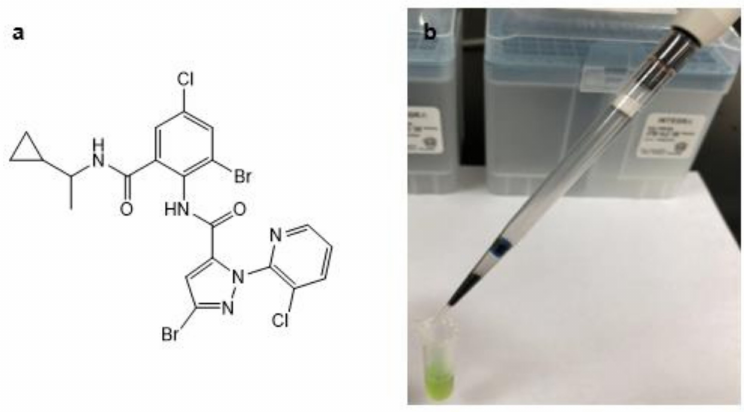
Figure 1. Molecular structure of CYCP ( a ) and a photograph of DPX apparatus ( b